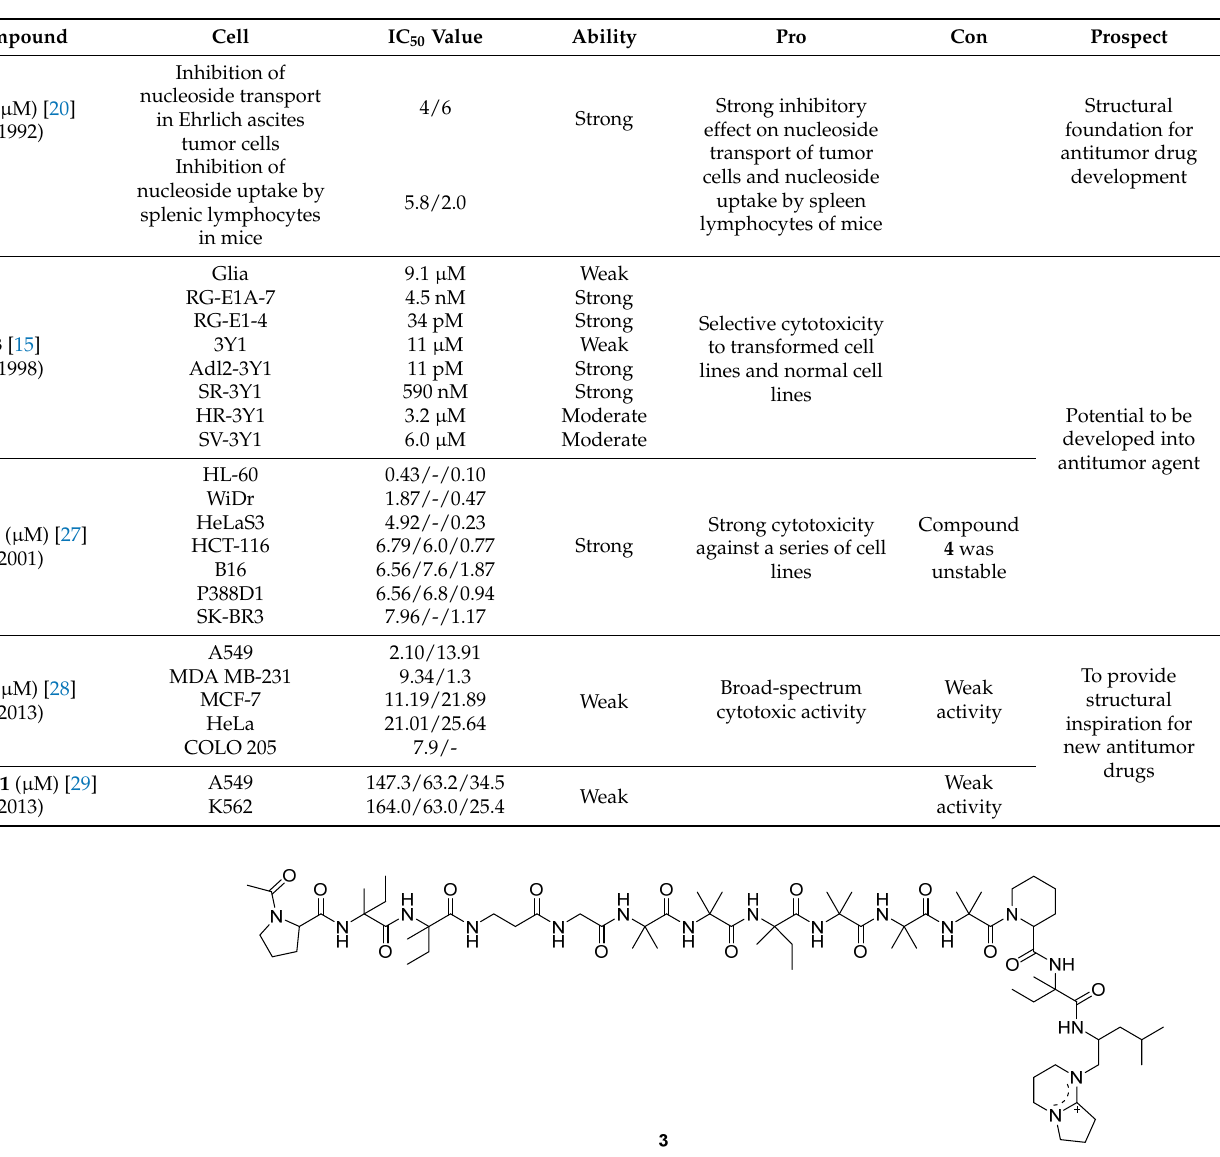
Table 1. Compounds with cytotoxic activity.